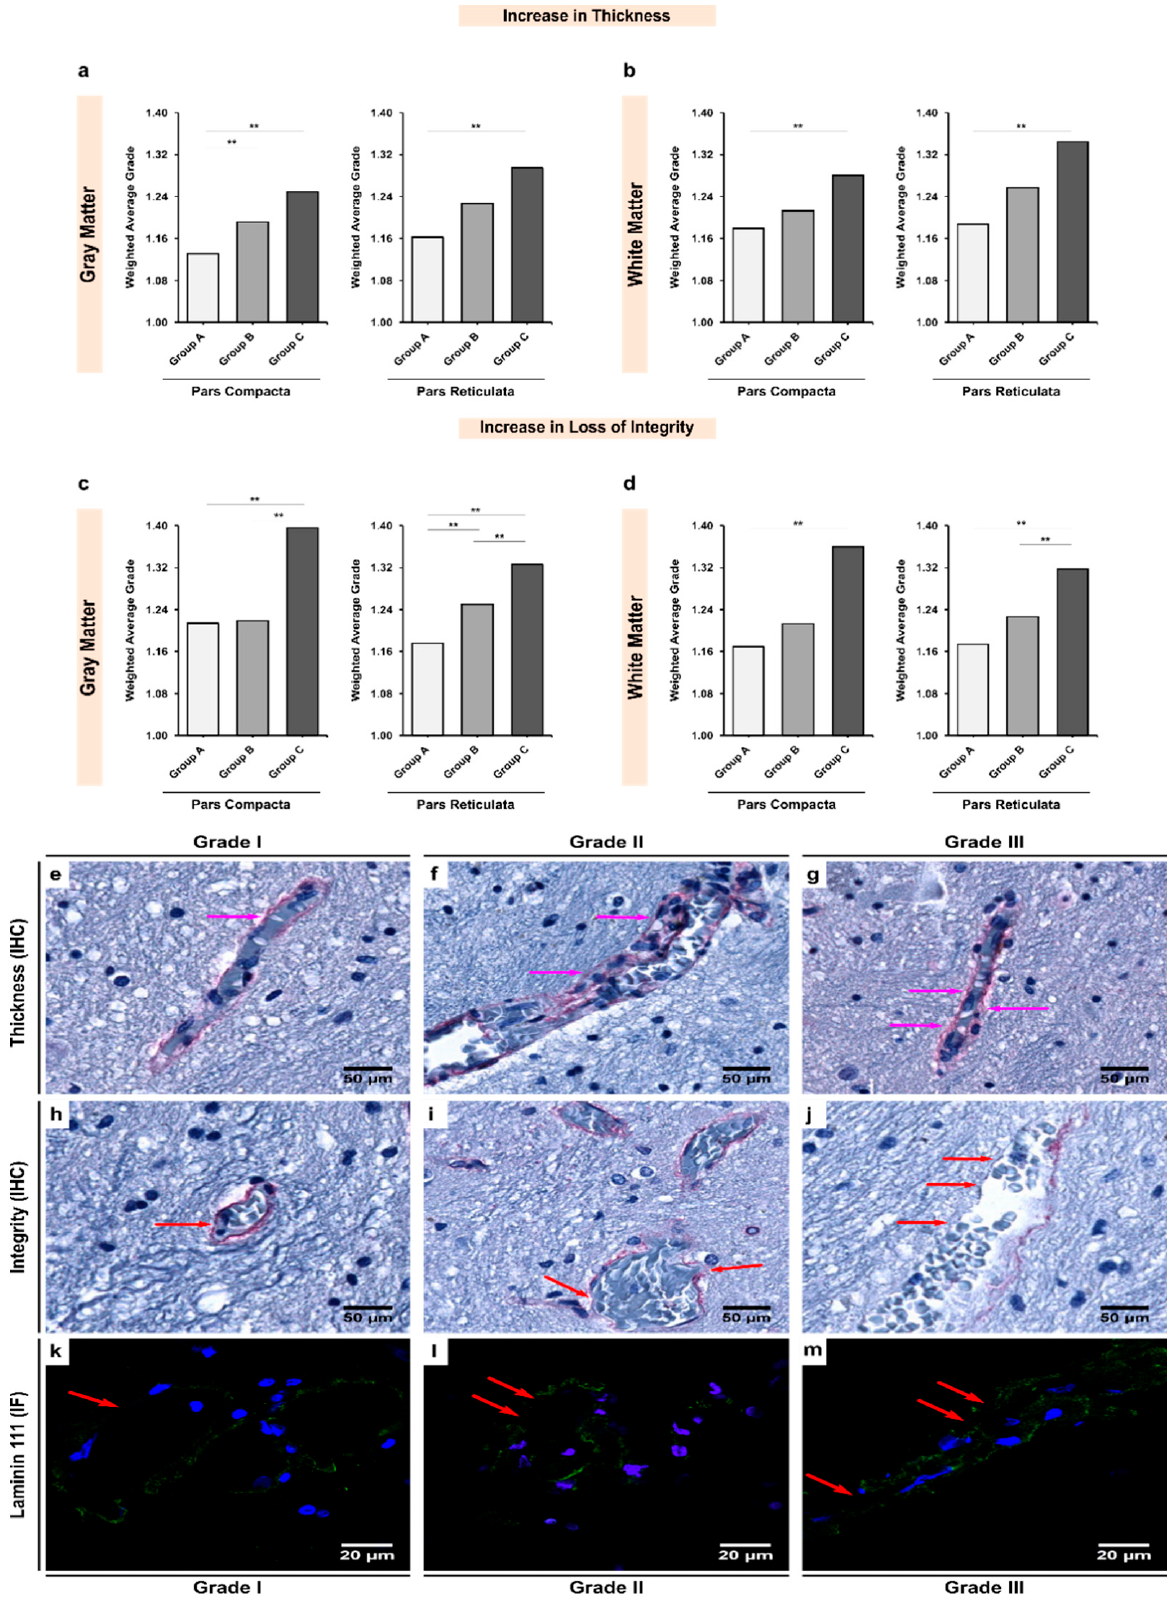
Figure 4. Inter-group analysis of the increase in ( a , b ) thickness and ( c , d ) loss of integrity of the BM based on expression of laminin-111 in the microvessels in the ( a , c ) gray matter and ( b , d ) white matter of the SN region. Group A represent controls, group B represents young alcoholics, whilst group C represents chronic alcoholics. The bar plots indicate the weighted average grading of all the visualized blood vessels in each group; ** indicates a significant difference between the groups ( p < 0.05 with Bonferroni correction is considered as significant). Representative photomicrographs showing the different grades of thickness and integrity of BM based on expression of laminin-111 as